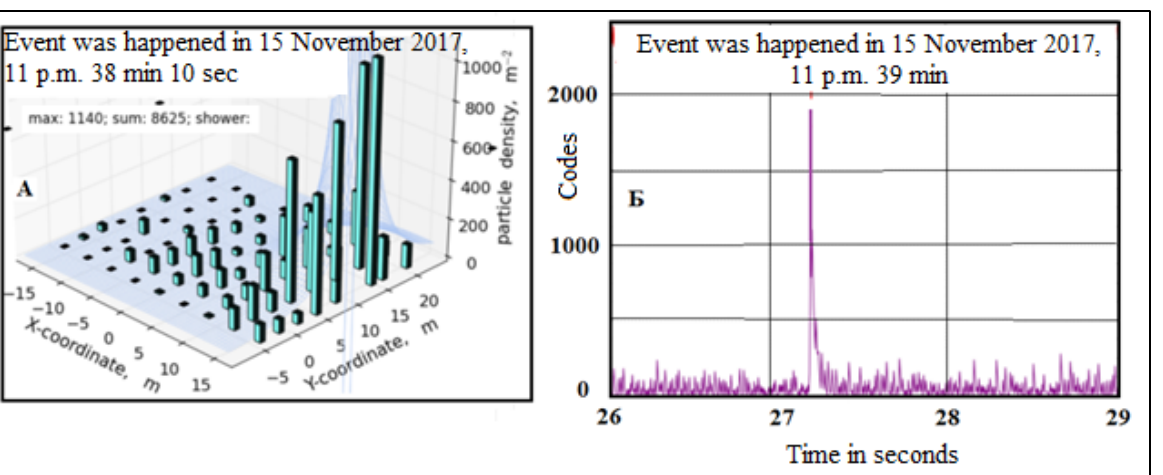
Figure 7. Results of long-term measurements with an acoustic detector presented on the web page of Tien Shan station: amplitudes of recorded acoustic pulses exceeding 300 code.